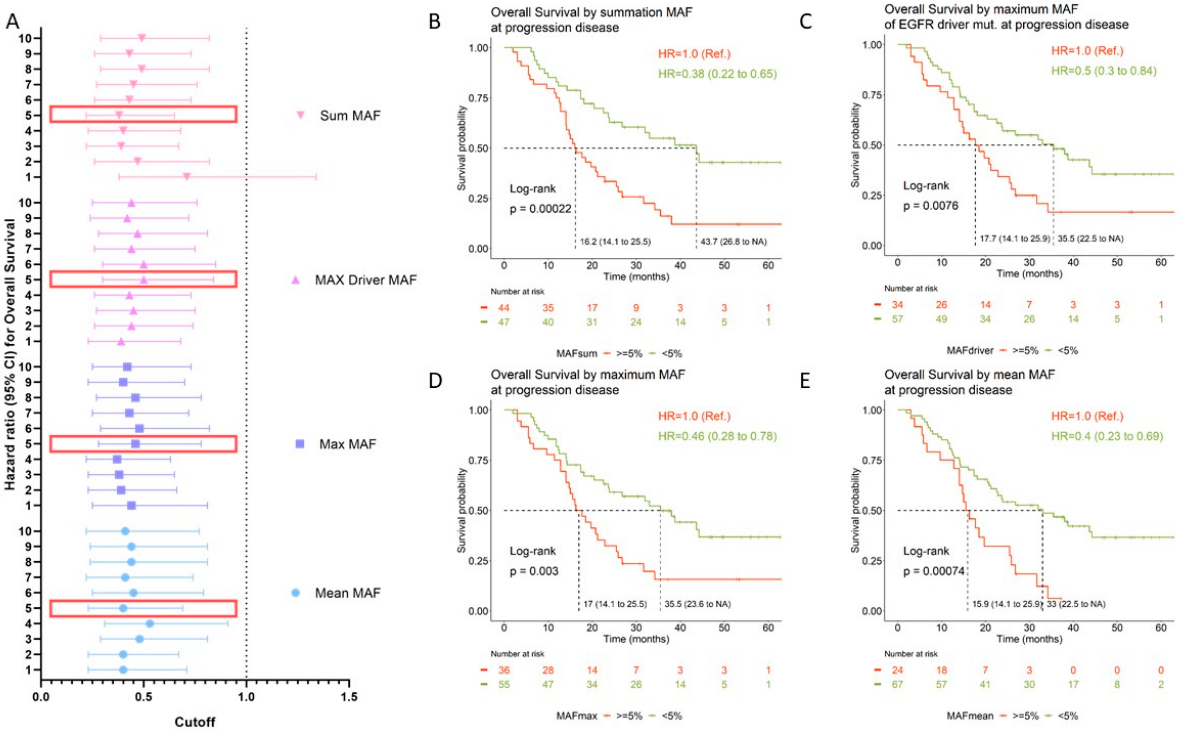
Figure 4. OS according to ctDNA levels upon disease progression. ( A ) Hazard ratios (HRs) for OS are depicted for each MAF cutoff value and according to the quantification approach (mean: blue circles; max: blue squares; max driver: purple triangles; sum: pink upside-down triangles). The hor- izontal dashed line delimits the confidence intervals. Large red rectangles highlight the MAF cutoff represented in the Kaplan–Meier curves. ( B – E ) Kaplan–Meier curves for OS according to MAF cut- off (5%) measured using different methodological approaches. Median OS for each group; log-rank p -values and HRs are shown at the left bottom side and right upper side, respectively. Mean MAF was calculated as the mean of the MAF from the set of all variants detected for each sample. Max MAF was defined as the maximum MAF among the set of variants detected for each sample. Driver